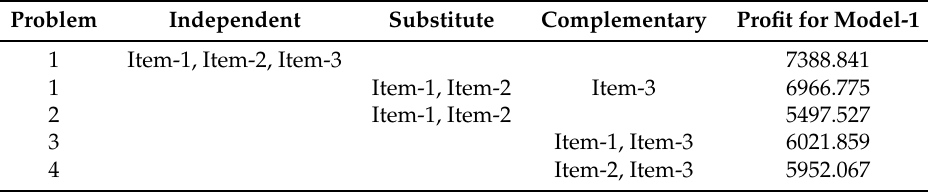
Table 12. Results for the different combinations of substitute and complementary items.